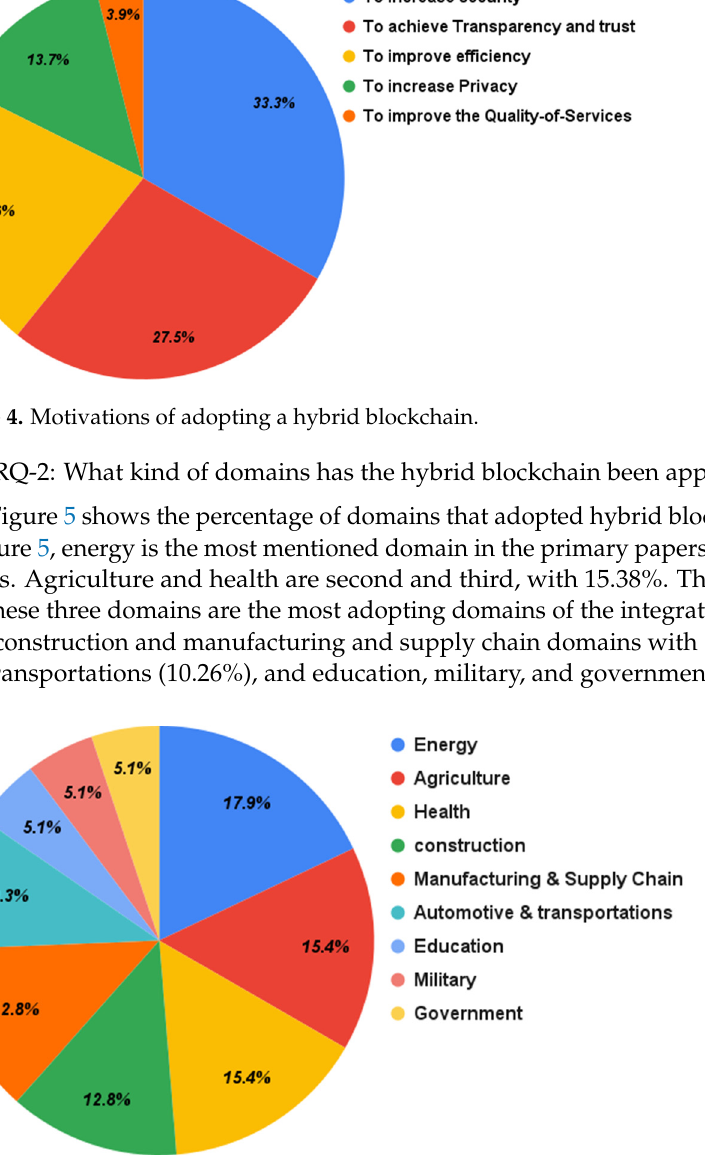
Figure 5. Hybrid blockchain domains that have been adopted.